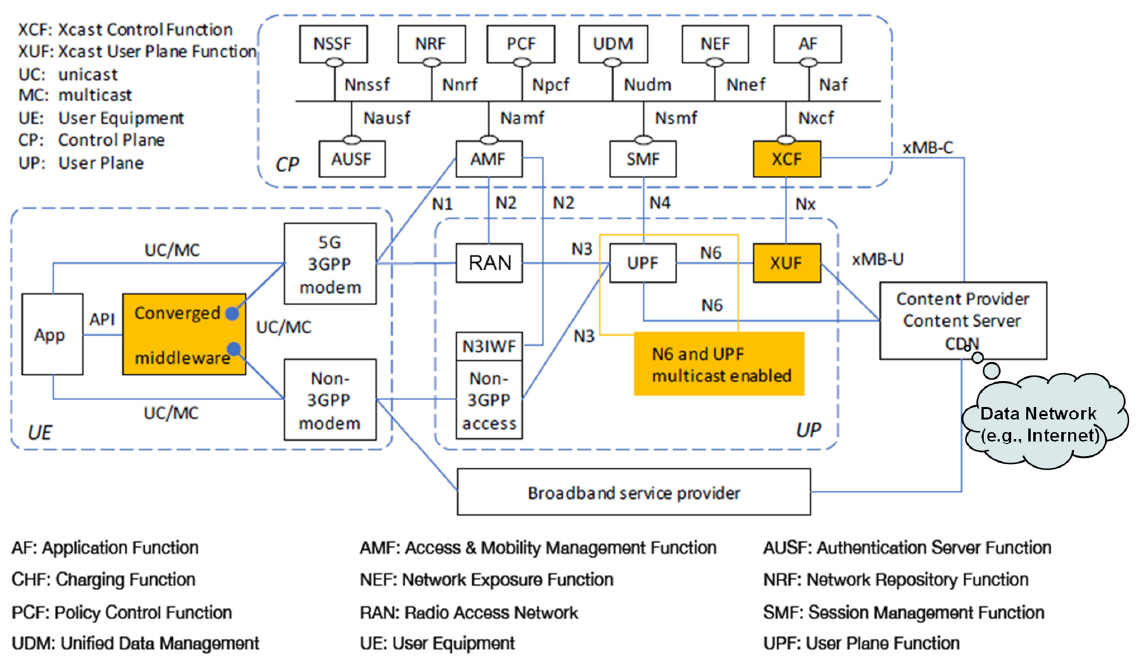
Figure 1. Enhanced 5G System Architecture for Terrestrial Multicasting and Broadcasting Network